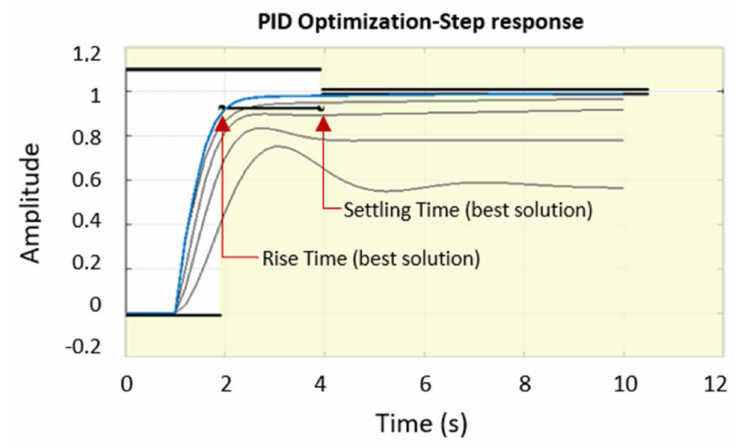
Figure 4. Tuning of the PID controller using the MATLAB optimization